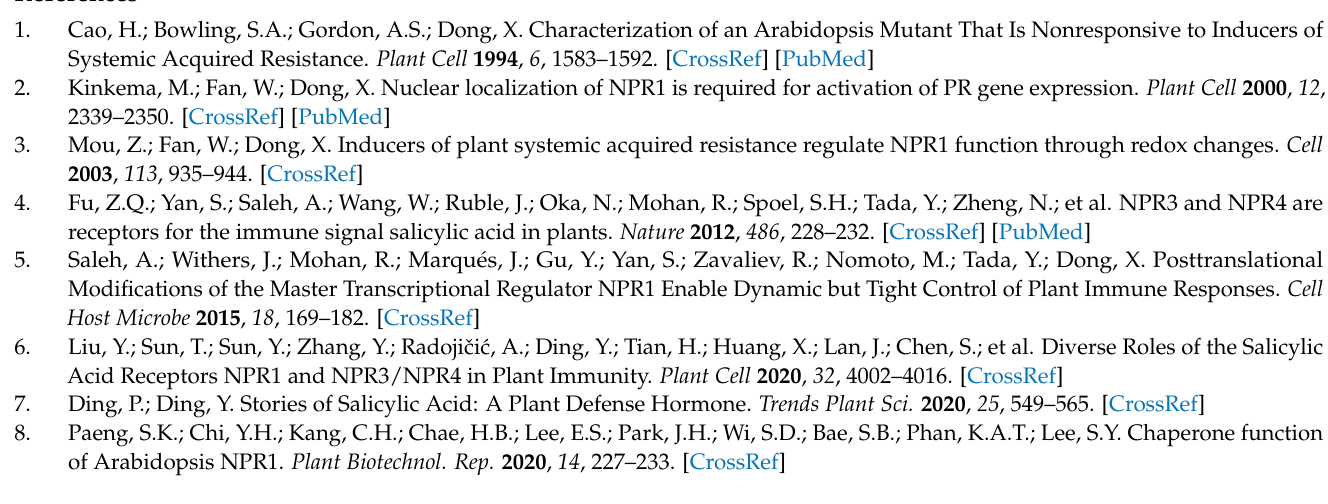
framed; Figure S3: RNA-seq data showing the stable expression of genes coding proteins potentially directly or indirectly interacting with NPR1-like proteins in strawberry during C. fructicola